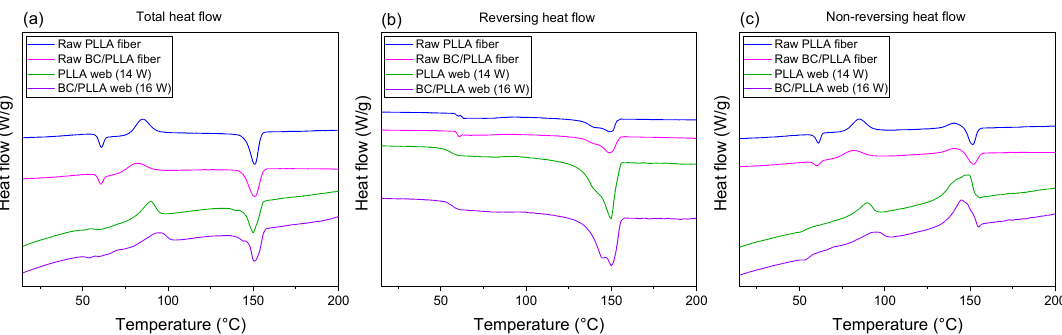
Figure 13. WAXD profiles at the azimuthal angles of 0 and 90° for raw ( a ) PLLA and ( b ) BC/PLLA fibers.